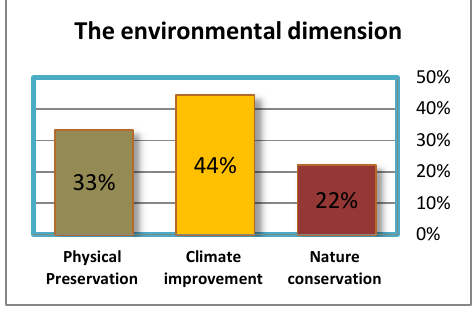
Fig. 16. Rate of achieving environmental dimension indicators for landscape activation, (by the researchers).